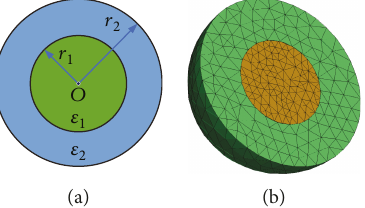
Figure 4: Geometrical model of a coated dielectric sphere. (a) Geometrical parameter de fi nition and (b) cross section of the nonconformal meshes.